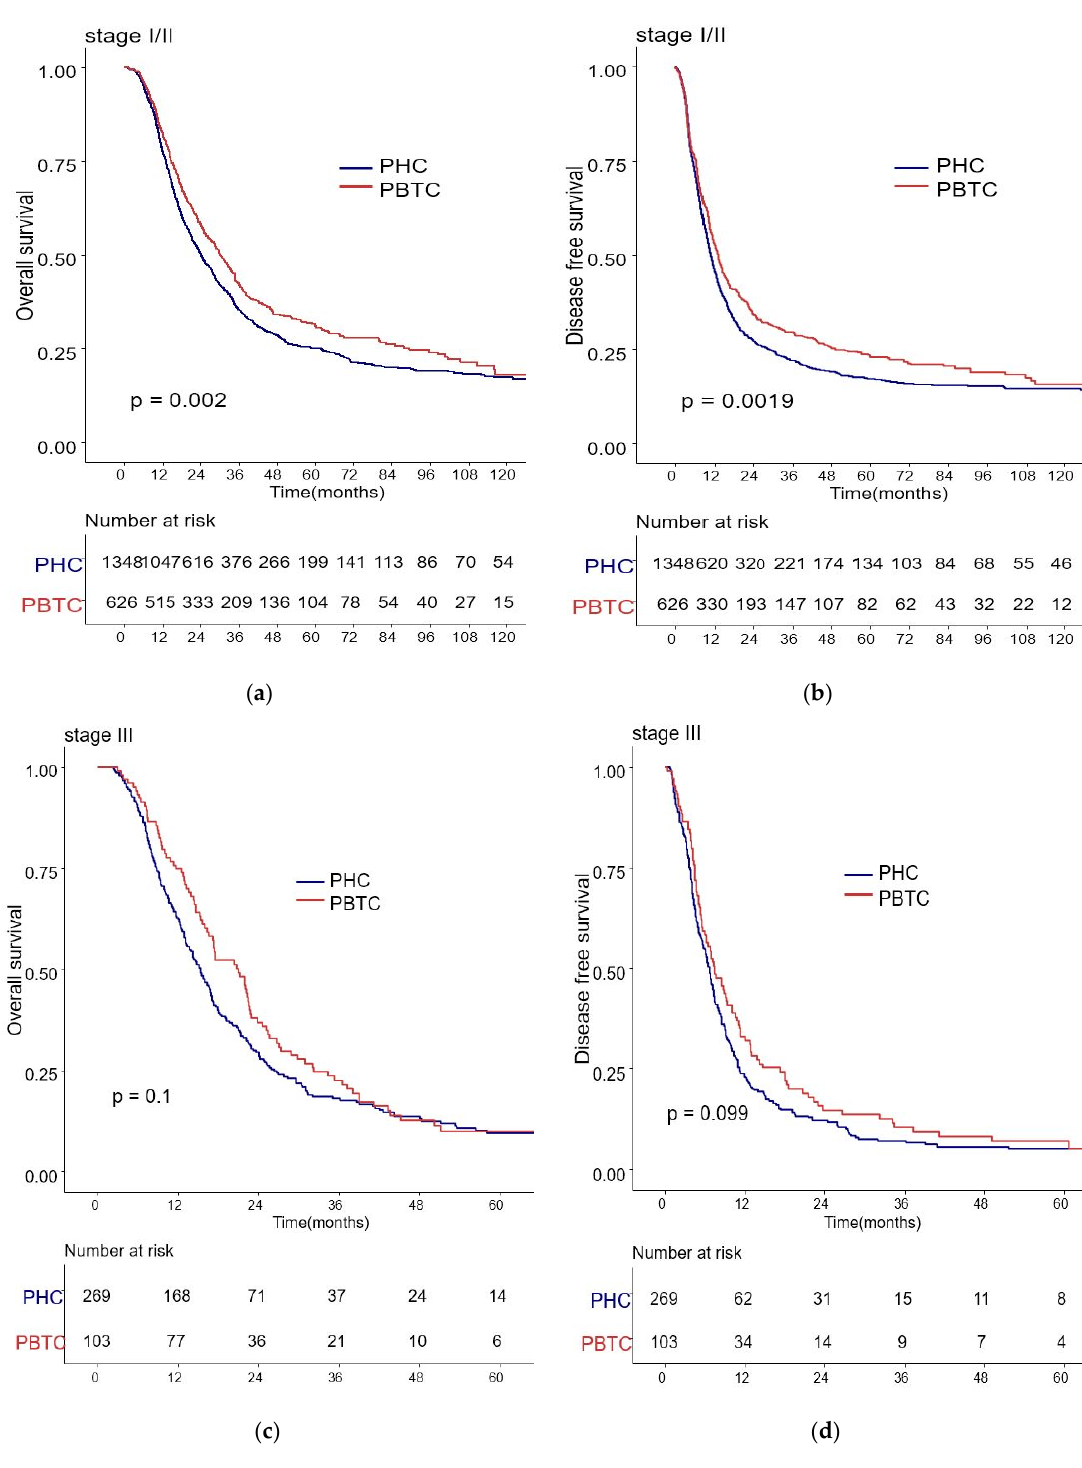
Figure 2. Kaplan–Meier survival curves of the cases in pancreatic head cancer (PHC) group ( n = 1348) and pancreatic body/tail cancer (PBTC) group ( n = 626), stratified according to cancer stage (I/II or III). ( a ) The median overall survival (OS) and estimated 1-, 3-, and 5-year OS rates for stage I/II were 24.0 months and 77.7%, 27.9%, and 14.8% in the PHC group, and 30.0 months and 82.3%, 33.4%, and 16.6% in the PBTC group, respectively ( p = 0.002). ( b ) The median disease-free survival (DFS) and estimated 1-, 3-, and 5-year DFS rates for stage I/II were 10.0 months and 46.0%, 16.4%, and 9.9% in the PHC group, and 13.0 months and 52.7%, 23.5%, and 13.1% in the PBTC group, respectively ( p = 0.0019). ( c , d ) However, no significant difference was found between PHC patients and those with stage III PDAC (overall survival: p = 0.1, disease-free survival: p = 0.099).